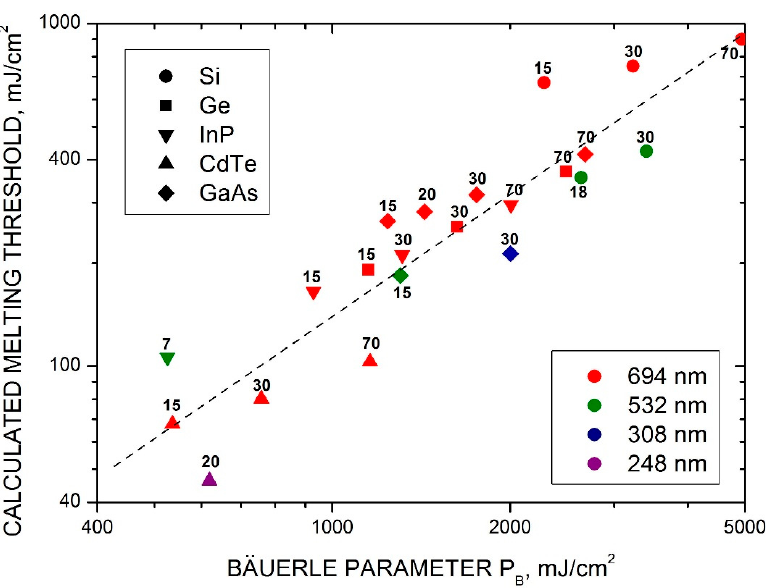
Figure 4. Calculated melting thresholds of the studied semiconductors for different laser wavelengths as a function of the Bäuerle parameter, P B , Equation (8). The numbers above the points correspond to the laser pulse duration in nanoseconds. The line represents a power-law least-square fit of the data. The parameter P B predicts a growth of the melting threshold with the laser pulse duration as τ L0.5 . However, as was noticed above, this is not always the case according to our simulations. Some semiconductors (Ge, CdTe, InP) follow closely the τ L0.5 dependence, while others (Si, GaAs) demonstrate weaker dependencies (Table 1 and Figure 4). This finding agrees with calculations based on the theory in [26], which also predicts a nearly τ L0.5 dependence for CdTe over a wide range of pulse durations [28] and a much weaker dependence for Si [27]. This is probably mainly due to a difference in the thermal diffusivity, D , of the materials. Thus, at room temperature, D ≈ 0.8 cm 2 /s for Si, and it is around 0.35 cm 2 /s for Ge, InP and CdTe. A higher thermal diffusivity results in a higher heat diffusion length and smaller in-depth temperature gradients and thus in a lower heat flow from the surface at an increased pulse duration. The temperature dependencies of material parameters (included in our model simulations) can additionally affect the pulse duration dependence of the melting